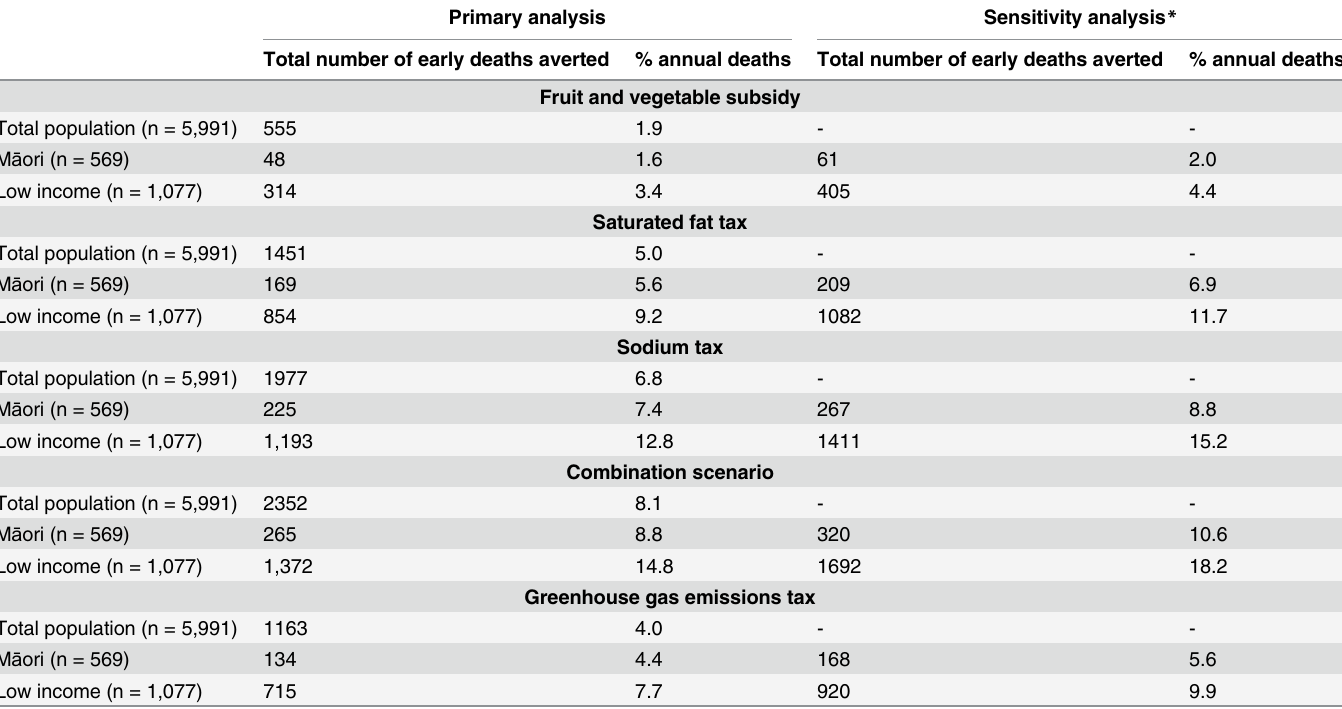
Table 5. Sensitivity analysis: Changes in total mortality when own-price elasticity values are increased for M ā ori and low income